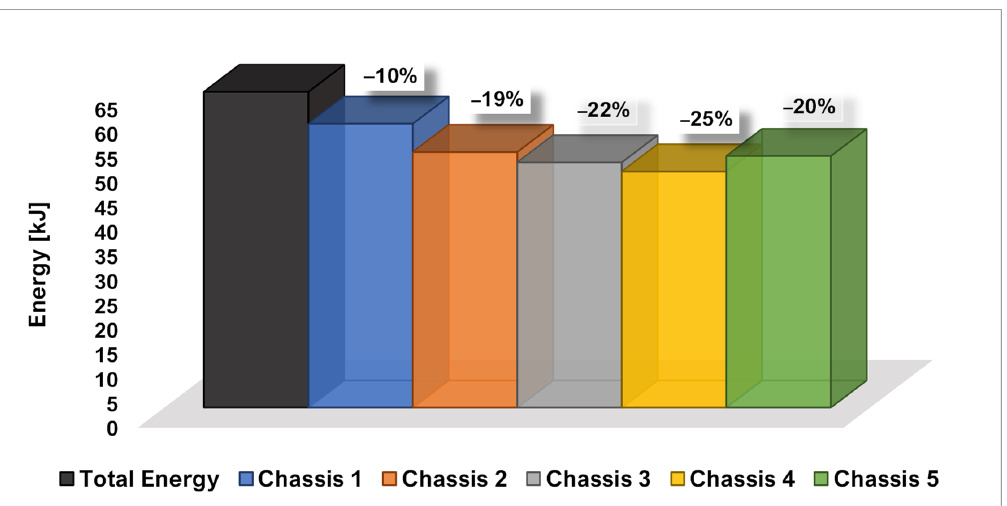
Figure 12. Comparison of energy detected in the safety cage.